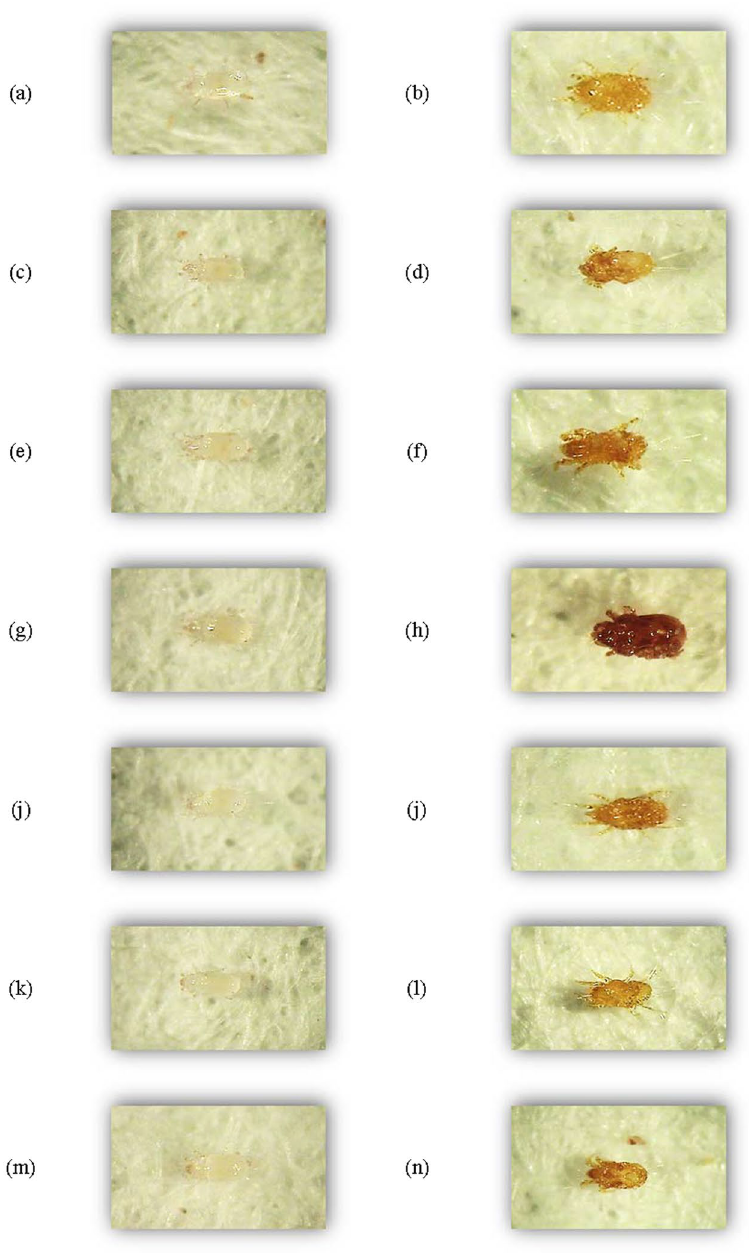
Figure 2. Color deformation of hydroxybenzaldehyde and methylbenzaldehyde analogues with (mixed at 9:1 ratio) and without 2,3-dihydroxybenzaldehyde to T . putrescentiae for 24 h at a dose of each LD 95 values. ( a ) 2-Methylbenzaldehyde without 2,3-dihydroxybenzaldehyde; ( b ) 2-Methylbenzaldehyde with 2,3-dihydroxybenzaldehyde; ( c ) 3-Methylbenzaldehyde without 2,3-dihydroxybenzaldehyde; ( d ) 3-Methylbenzaldehyde with 2,3-dihydroxybenzaldehyde; ( e ) 4-Methylbenzaldehyde without 2,3-dihydroxybenzaldehyde; ( f ) 4-Methylbenzaldehyde with 2,3-dihydroxybenzaldehyde; ( g ) 2,3-Dimethylbenzaldehyde without 2,3-dihydroxybenzaldehyde; ( h ) 2,3-Dimethylbenzaldehyde with 2,3-dihydroxybenzaldehyde; ( i ) 2,4-Dimethylbenzaldehyde without 2,3-dihydroxybenzaldehyde; ( j ) 2,4-Dimethylbenzaldehyde with 2,3-dihydroxybenzaldehyde; ( k ) 2,5-Dimethylbenzaldehyde without 2,3-dihydroxybenzaldehyde; ( l ) 2,5-Dimethylbenzaldehyde with 2,3-dihydroxybenzaldehyde; ( m ) 2,4,5-Trimethylbenzaldehyde without 2,3-dihydroxybenzaldehyde; ( n ) 2,4,5-Trimethylbenzaldehyde with